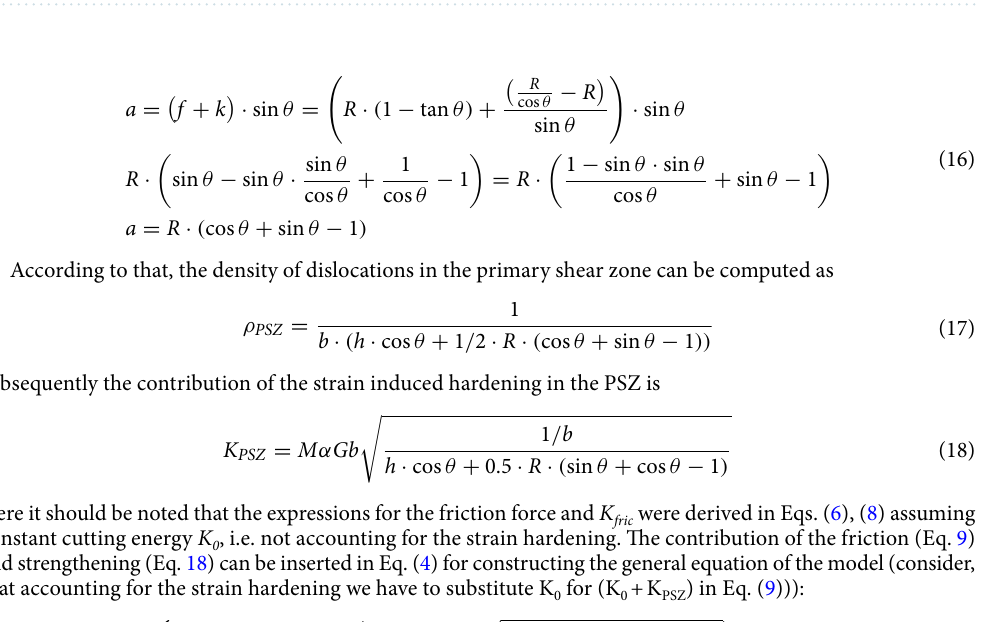
Table 5. Parameters for modelling Aluminium